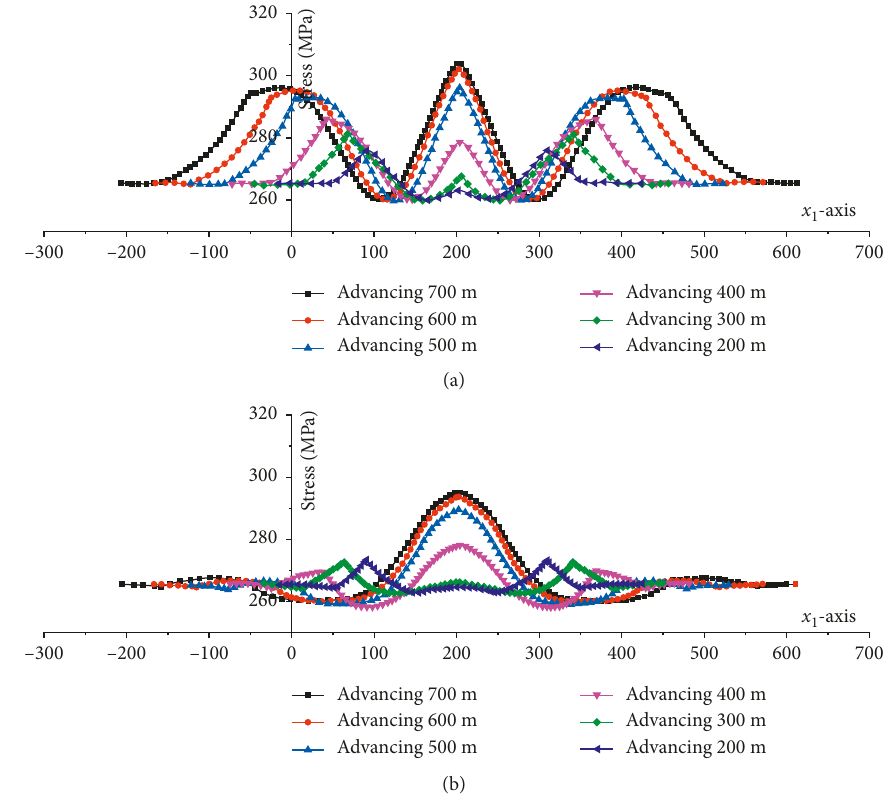
Figure 17: Von Mises stresses of the buried pipeline as the working face advancing: (a) Von Mises stresses distribution on the top of the pipeline and (b) Von Mises stresses distribution at the bottom of the